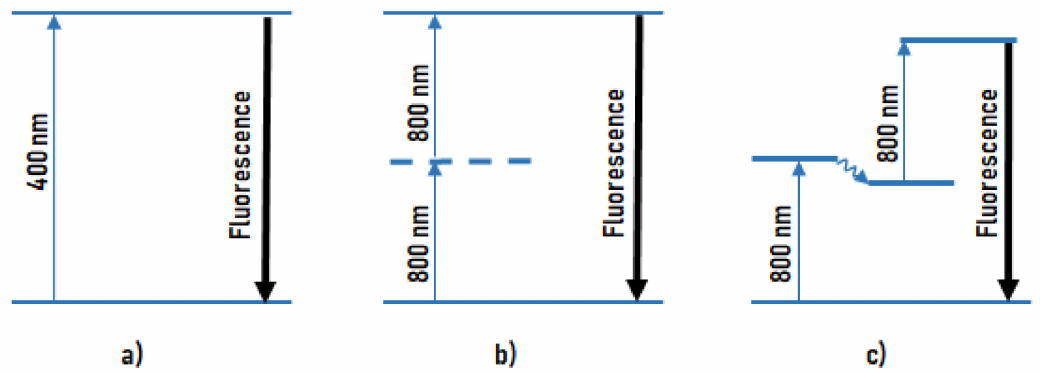
Figure 1. The principle of dermatofluoroscopy. Di ff erent modes of excitation of fluorescence in the visible spectral region: ( a ) conventional fluorescence excitation by one photon (e.g., 400 nm); ( b ) excitation by simultaneous absorption of two photons via an only virtual energy level (e.g., 800 nm, preferably from a femtosecond laser); ( c ) excitation by stepwise absorption of two photons (e.g., 800 nm, preferably from a nanosecond laser) via a real intermediate energy